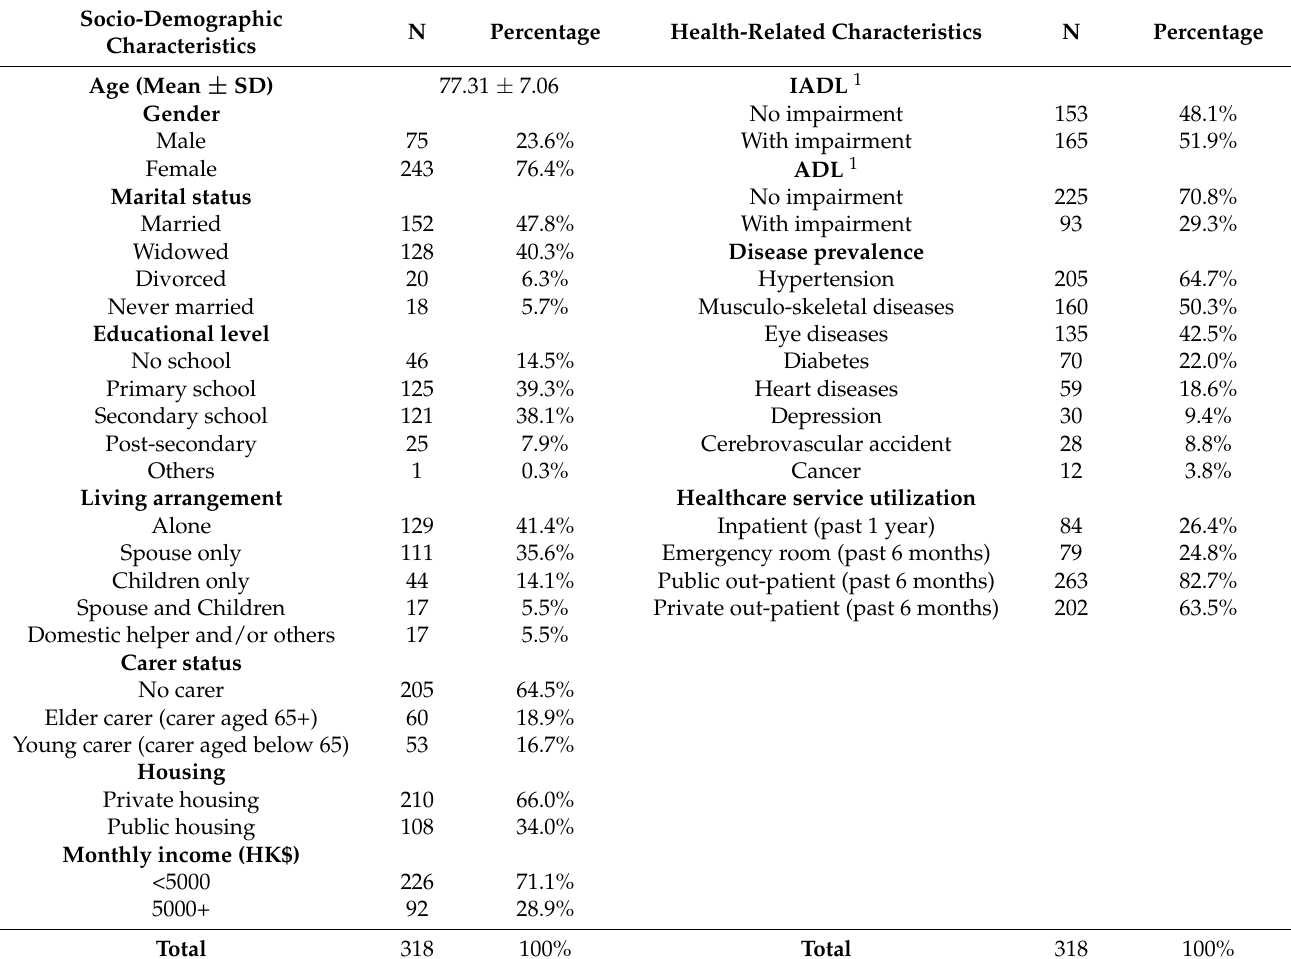
Table 2. Socio-demographic and health-related characteristics of the survey